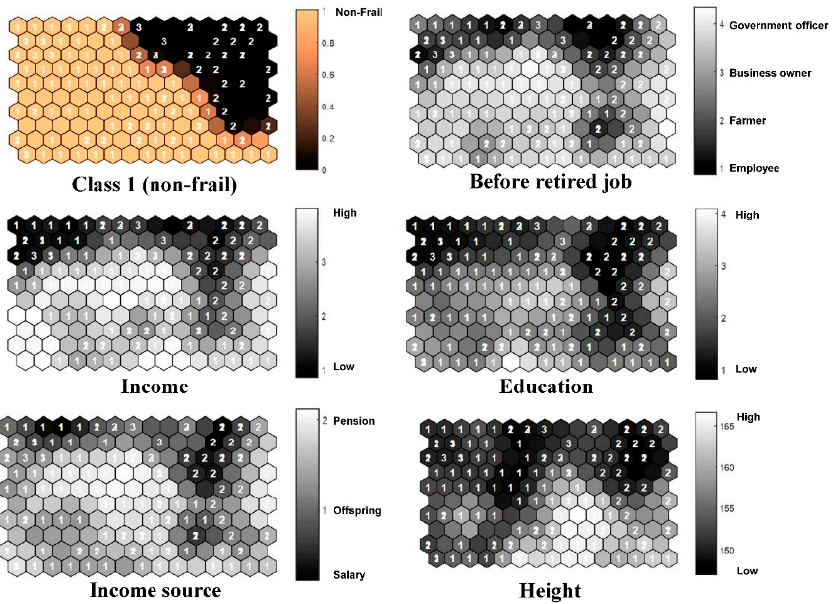
Figure 3. Component planes of the non-frail group and significant variables from the trained SOM model.